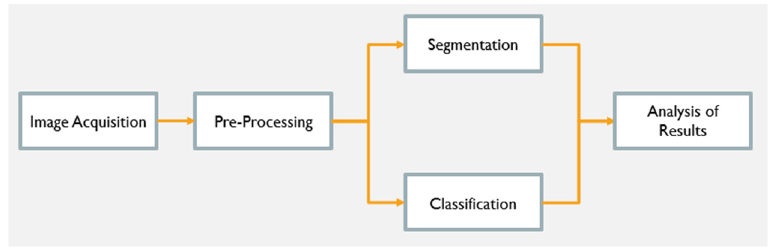
Figure 4. Generic architecture of the proposed system.